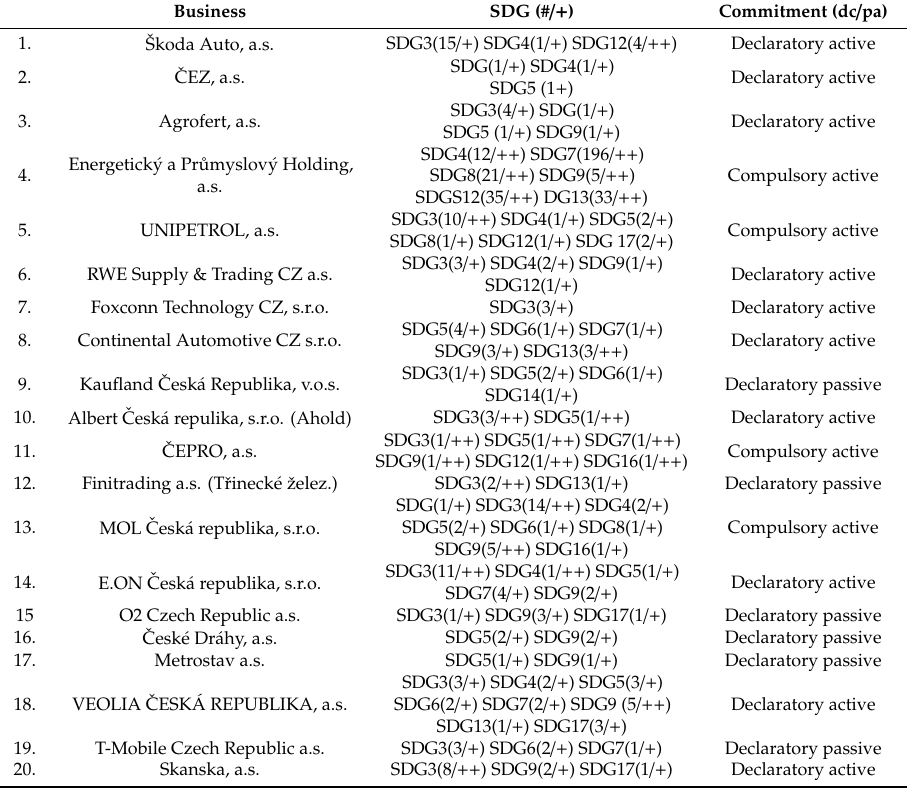
Table 5. Case study—first group—included SDGs, their frequency (#) and score ( + ), and their actionability (declaratory vs. compulsory) and nature (passive vs.